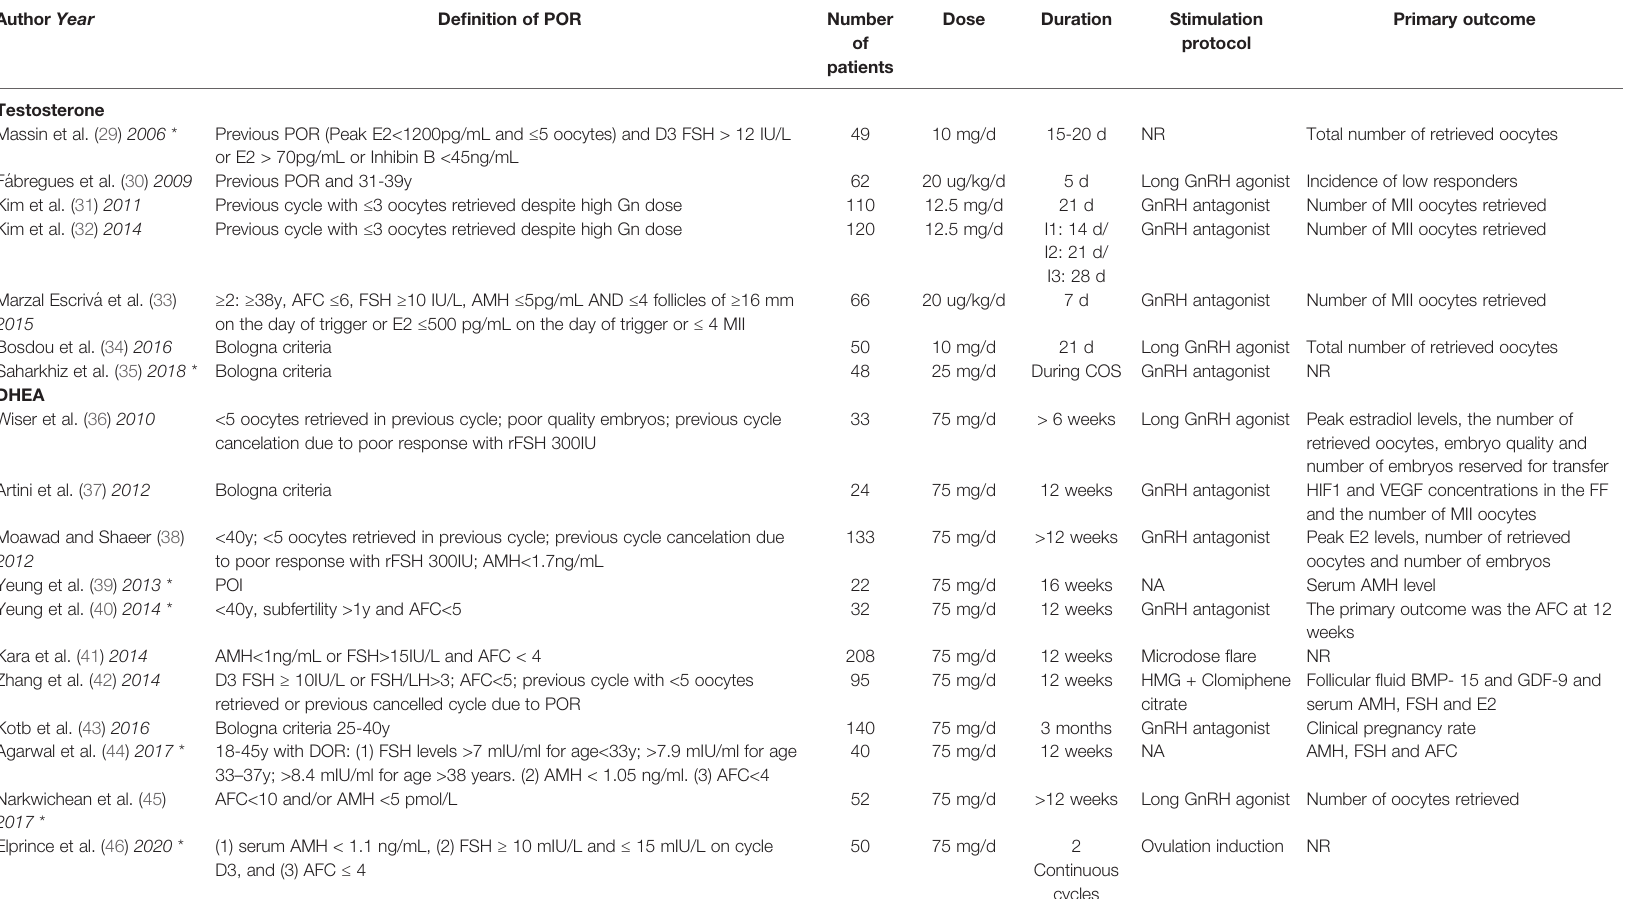
TABLE 1 | Published randomized controlled trials on the use of DHEA and Testosterone in DOR and POR patients.